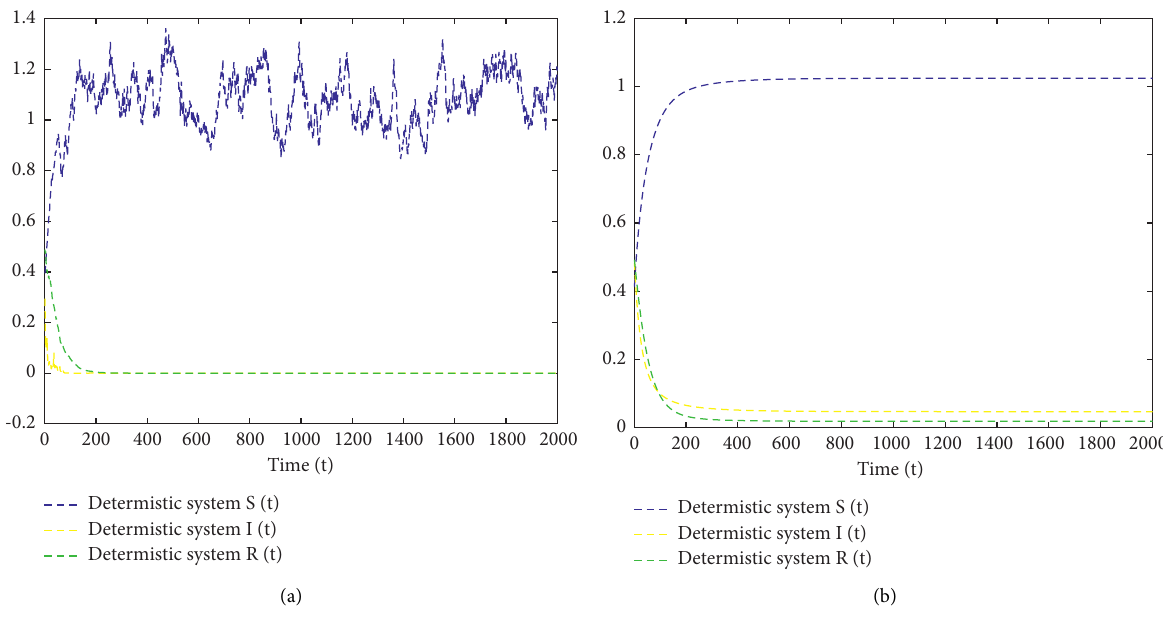
Figure 2: The subgraphs (a) and (b) denote the numerical simulation of the stochastic system (15) and deterministic system (1), respectively. R s < 1 < R shows that large white noise can lead to disease extinction, though the deterministic system is persistent. 0 0